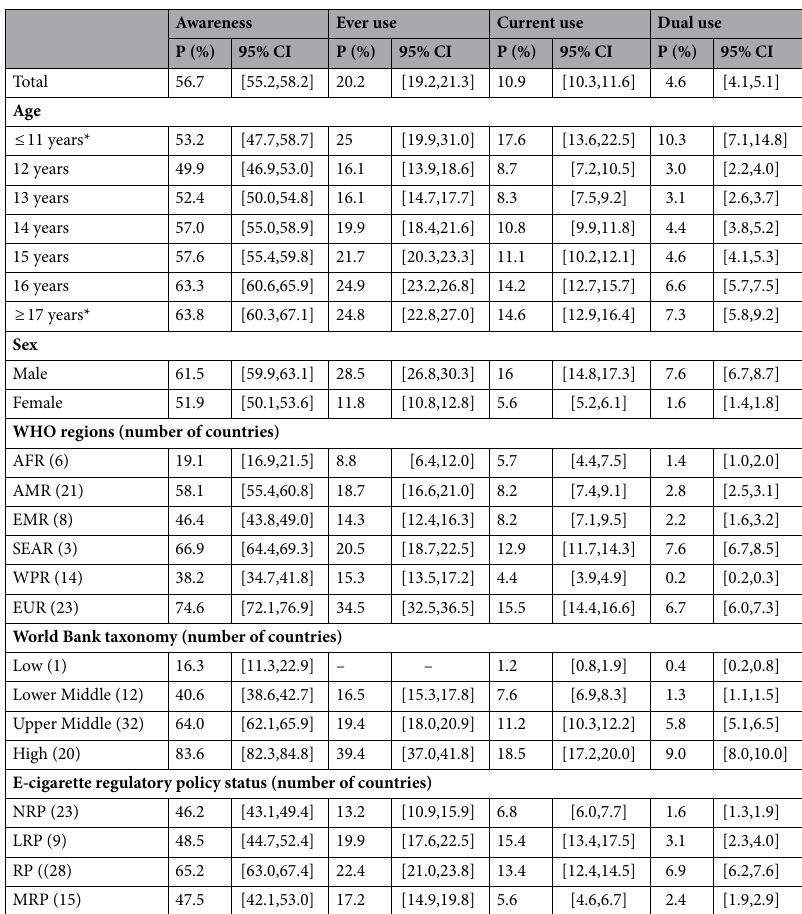
Table 2. Pooled estimates and their 95% CI of awareness about e-cigarette, ever and current e-cigarette use, and ‘dual use’ among the youth by their age, sex, and contextual factors (WHO regions, World Bank taxonomy, and regulatory policy status). All bivariate comparisons were statistically significant p < 0.001 by Chi-square statistic. *GYTS questionnaire did not collect exact age of those aged ≤ 11 years and ≥ 17